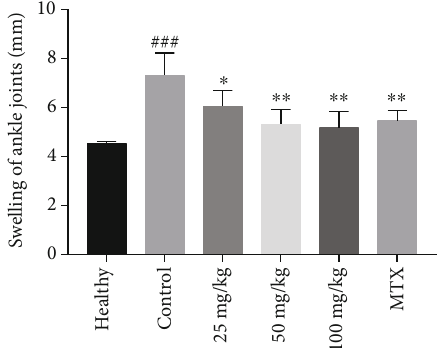
Figure 2: Therapeutic e ff ects of matrine and MTX on swelling of ankle joints in CIA rats. Ankle joint swelling was evaluated after treatment. Healthy: healthy group; control: CIA control group; 25mg/kg: low dosage matrine group; 50mg/kg: medium dosage matrine group; 100 mg/kg: high dosage matrine group; MTX: 2mg/kg methotrexate group. Compared to the healthy group, ### P < 0 : 001 ; compared to the control group, ∗ P < 0 : 05 ; ∗∗ P < 0 : 01